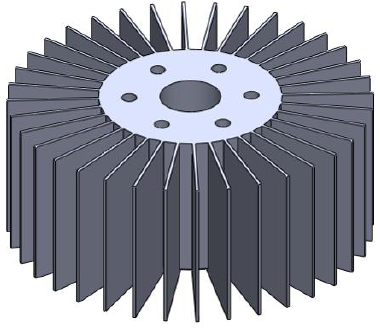
Figure 1. Cylindrical heat sink with radial plate fins.